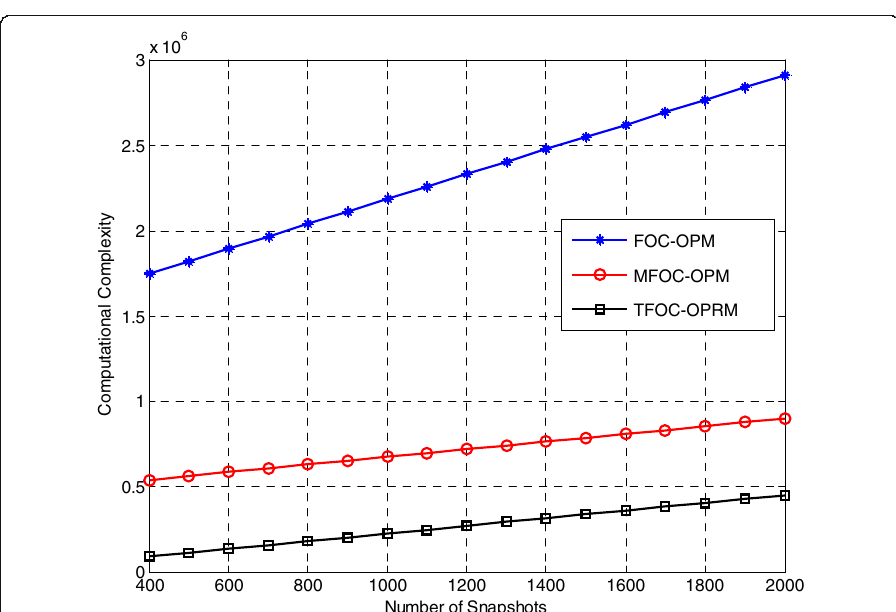
Fig. 6 Computational complexity comparison versus the number of